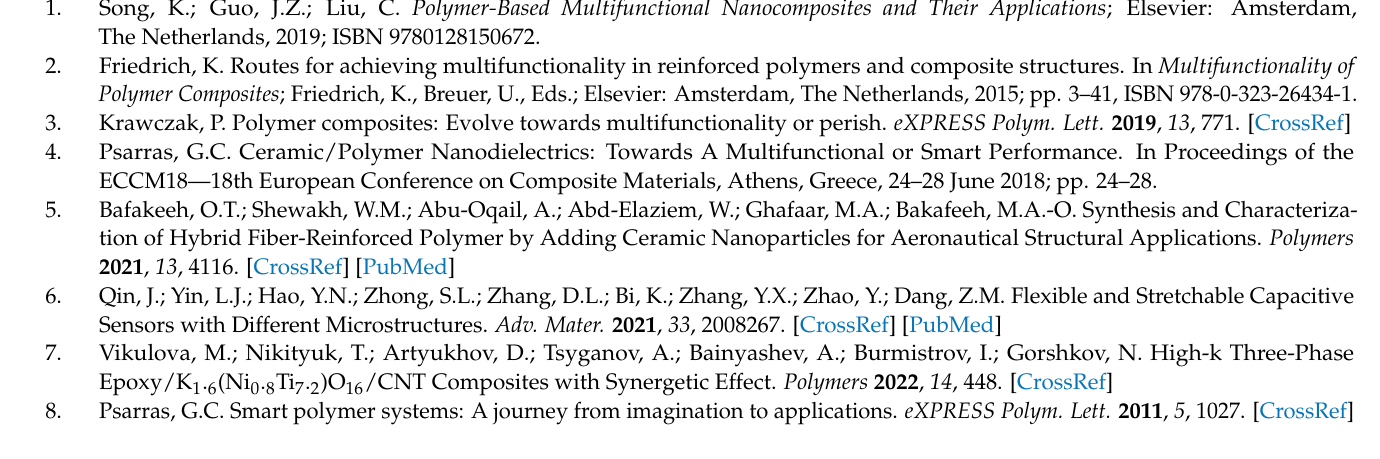
130 ◦ C; Figure S2: SEM image of the nanocomposite with 5 phr SrFe 12 O 19 /10 phr BaTiO 3 /epoxy, at a lower magnification; Figure S3: Representative stress-strain curves of all studied systems; Figure S4: TGA thermographs of all studied systems; Table S1: Glass transition temperatures determined via DSC, temperatures where the 5% mass loss occurs, and magnetic susceptibility of all studied